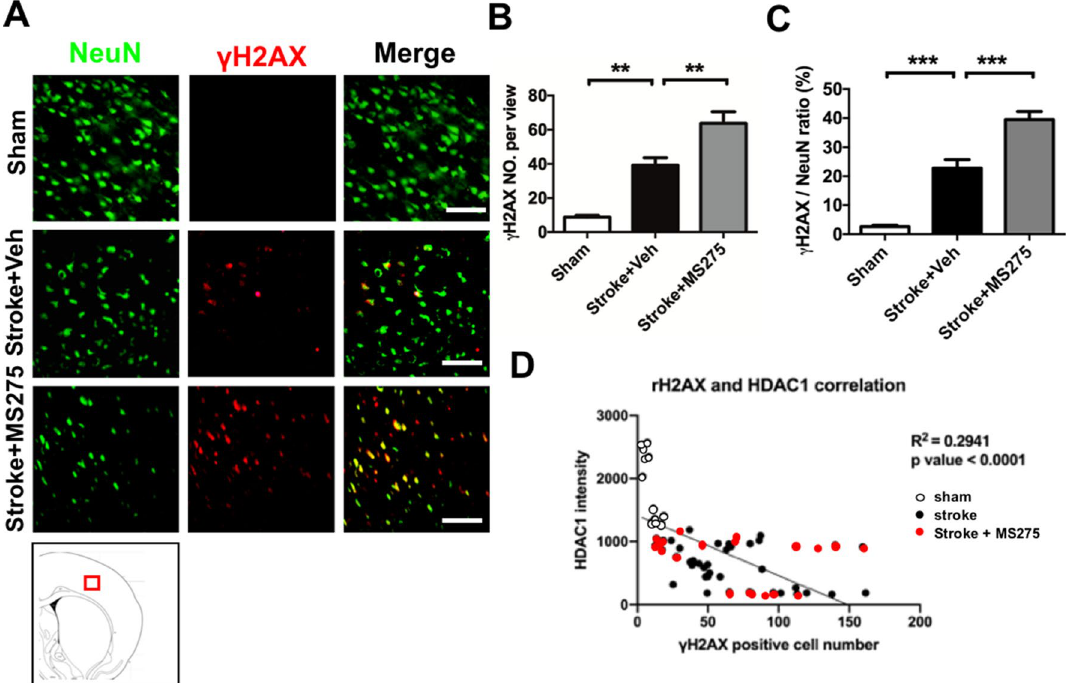
Figure 4. HDAC1 inhibition was related to levels of DNA damage in stroke. ( A ) Immunofluorescence staining of neuron cell (NeuN) and γH2AX with or without MS-275 respectively. A sketch map at the bottom